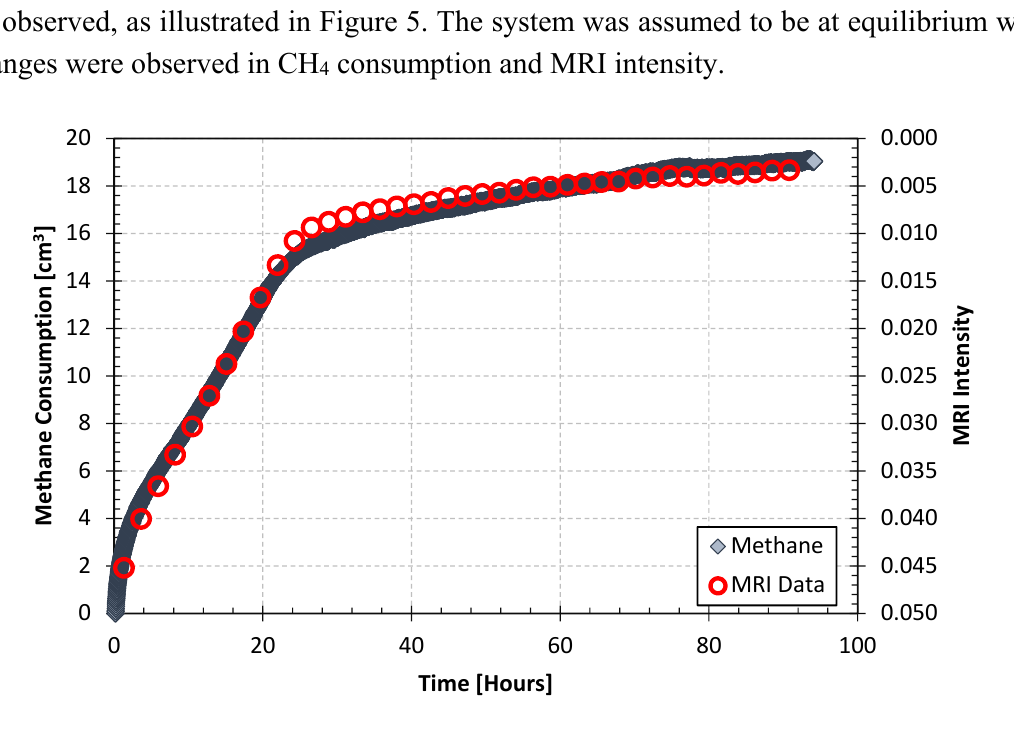
Figure 5. Comparison of CH 4 consumption and MRI intensity during hydrate formation for experiment c4 (S wi = 0.6). MRI intensity is plotted using inverse scale for easier